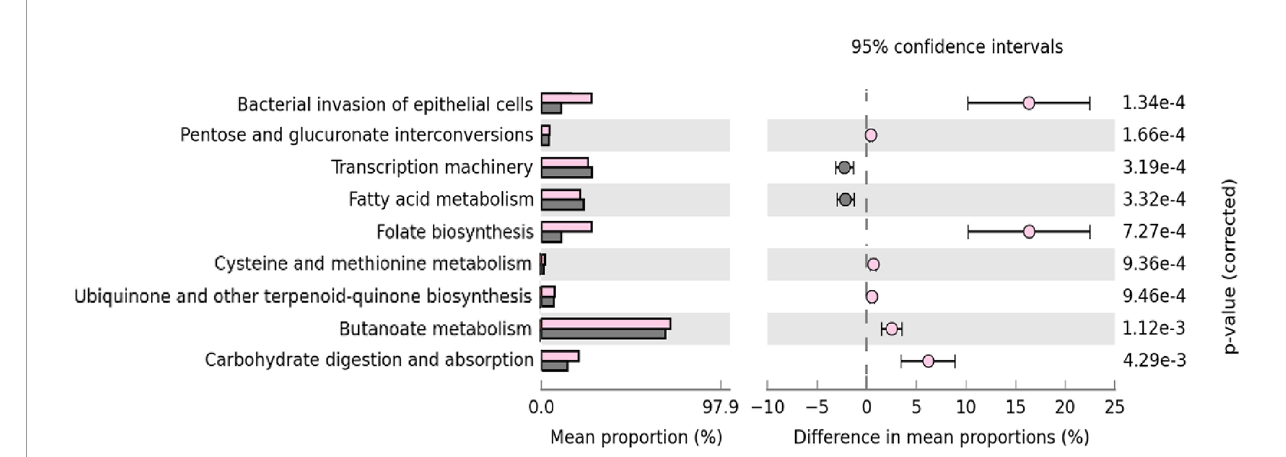
FIGURE 5 | Microbial metabolic pathways among IgA2+ bacteria are enriched in intestine adherence and active carbohydrate metabolism. GO analysis of the most representative metabolic pathways in predicting functional microbial metabolic pathways using PICRUSt analysis (KEGG level three). The abundance of nine statistically signi fi cant metabolic pathways between fi ve IgA2+ fecal bacteria samples from neonates fed with human colostrum for three days, in pink; and twenty- seven IgA- fecal bacteria samples from children fed with pasteurized milk, in gray. All values are represented as mean ±